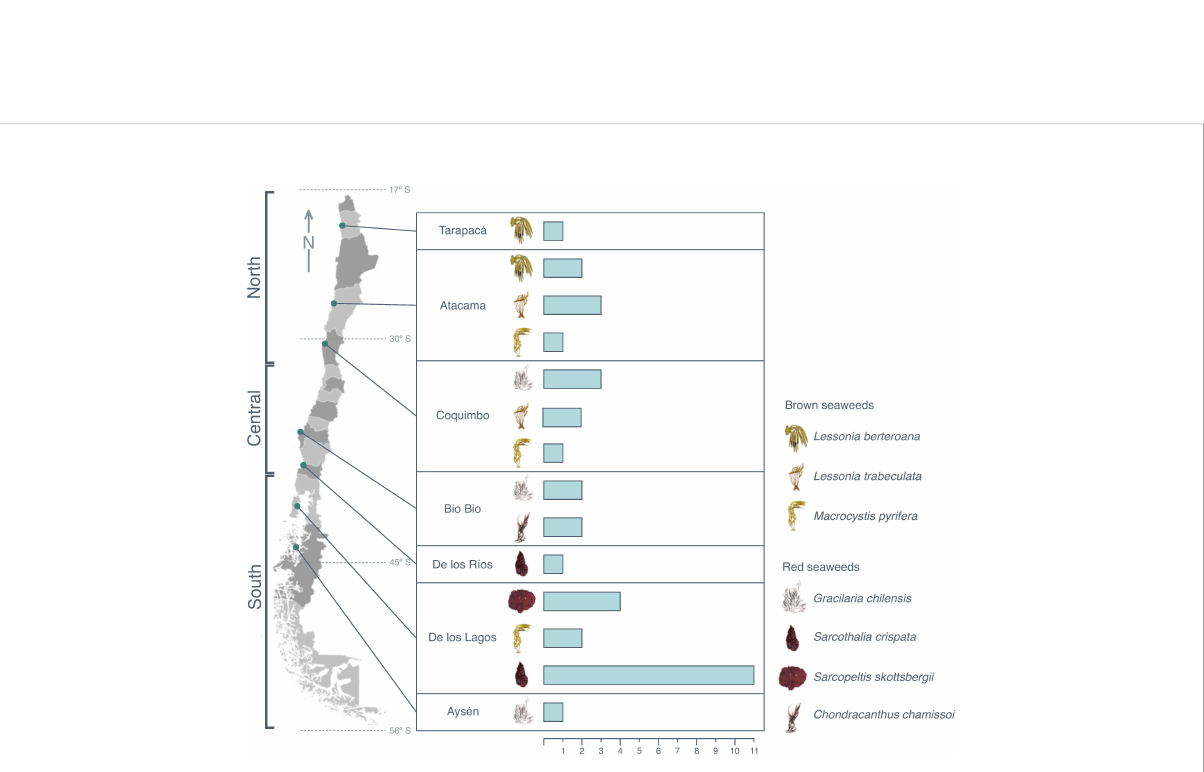
FIGURE 6 Number of seaweed-restocking activities along the Territorial Users Rights for Fisheries (TURF) in Chile by region and species for the period 2010 –